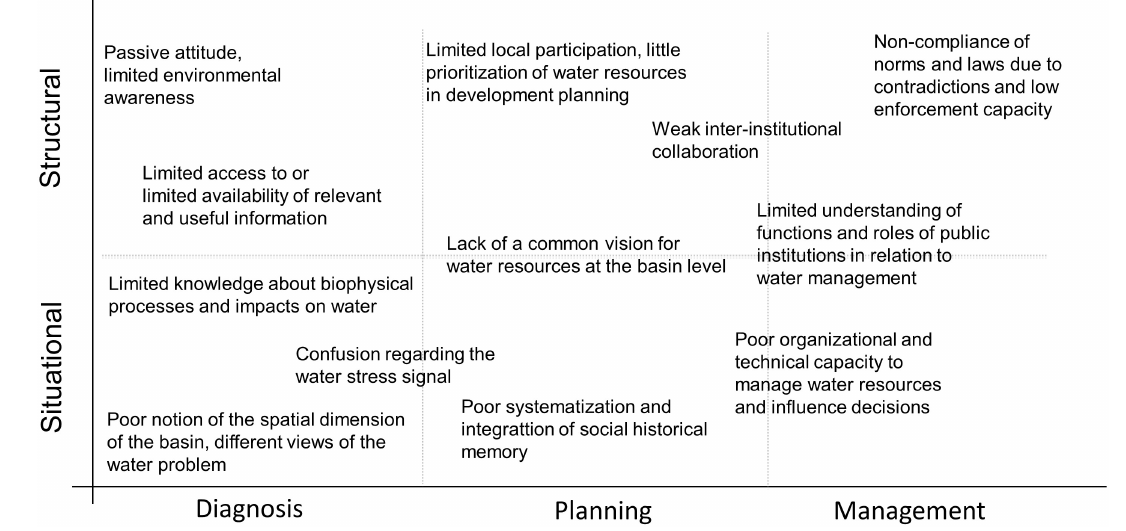
Fig. 3. Categorization of the main barriers to adaptation decision making for water security in the three model forests. The text highlights common barriers among the study sites. The x-axis organizes the barriers in terms of their relevance to the formal phases of adaptation decision making. The y-axis separates situational (contemporary) barriers from structural (legacy)